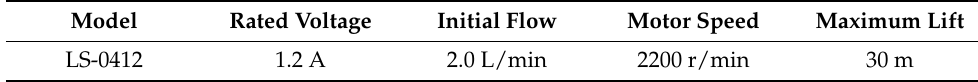
Table 1. Parameters of the Self-Priming Pump.